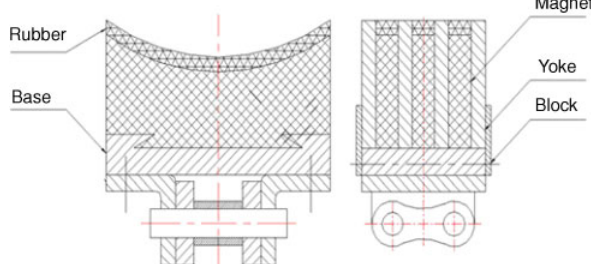
Figure 19 The magnetic unit using type A structure.